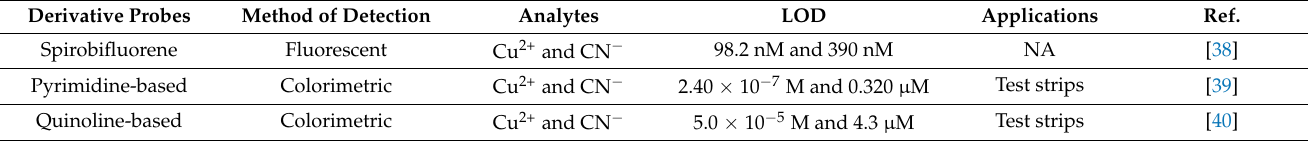
Table 1. Comparative summary on reported probes for sequential detection of Cu 2+ and CN − with current